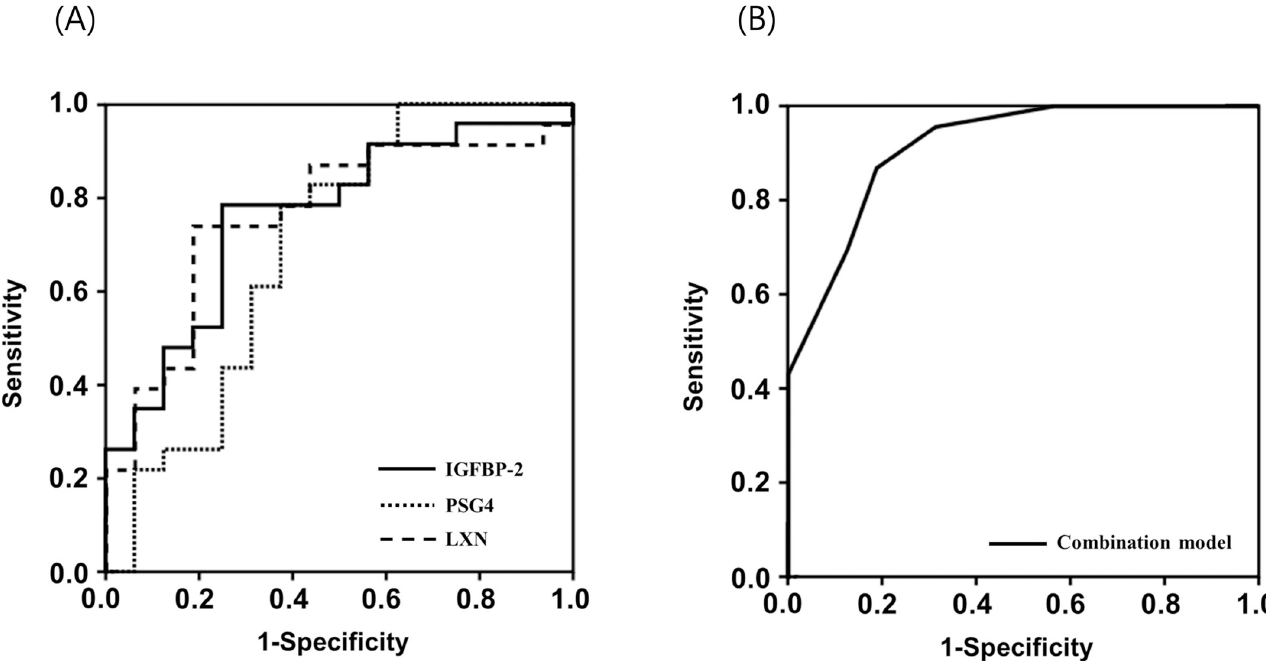
Fig 3. (A) Receiver operating characteristic (ROC) curves for plasma LEGEACGVYTPR (IGFBP-2), DVLTFTCEPK (PSG4), and FAVEEIIQK (LXN) levels in predicting spontaneous preterm delivery (SPTD) at < 33 weeks of gestation after cerclage placement (LEGEACGVYTPR: area under the curve [AUC] = 0.758, standard error [SE] = 0.079; DVLTFTCEPK: AUC = 0.696, SE = 0.095; and FAVEEIIQK: AUC = 0.764, SE = 0.080). (B) ROC curve for the best combined predictive model (including plasma LEGEACGVYTPR [IGFBP-2], DVLTFTCEPK [PSG4], and FAVEEIIQK [LXN]) for predicting SPTD at < 33 weeks of gestation. The AUC for the combined predictive model was 0.905 ( P < 0.05 for LEGEACGVYTPR vs the combined predictive model, P < 0.05 for DVLTFTCEPK vs the combined predictive model, and P < 0.05 for plasma FAVEEIIQK vs the combined predictive model).